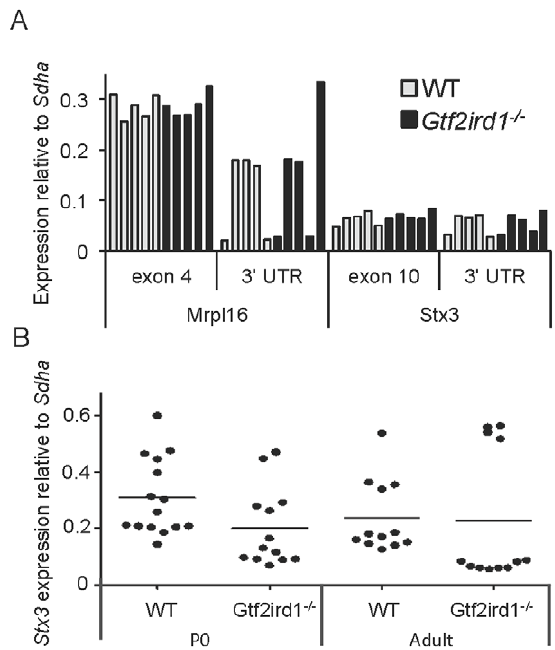
Figure 4. Expression of Stx3 and Mrpl16 show natural inter- individual variation. Expression is shown relative to the housekeep- ing gene Sdha . A. Expression in the heads of individual E15.5 mouse embryos. Considerable variation in expression within the 3 9 UTR can be seen for both genes within each genotype group. Each bar on the graph represents the expression level of an individual mouse, and the same 10 mice are shown in the same order for each primer pair. B. Expression of Stx3 in P0 and adult brain from Gtf2ird1 2 / 2 mice and control littermates. Each dot represents the expression of Stx3 in an individual mouse, and horizontal bars represent the mean expression level for the group.